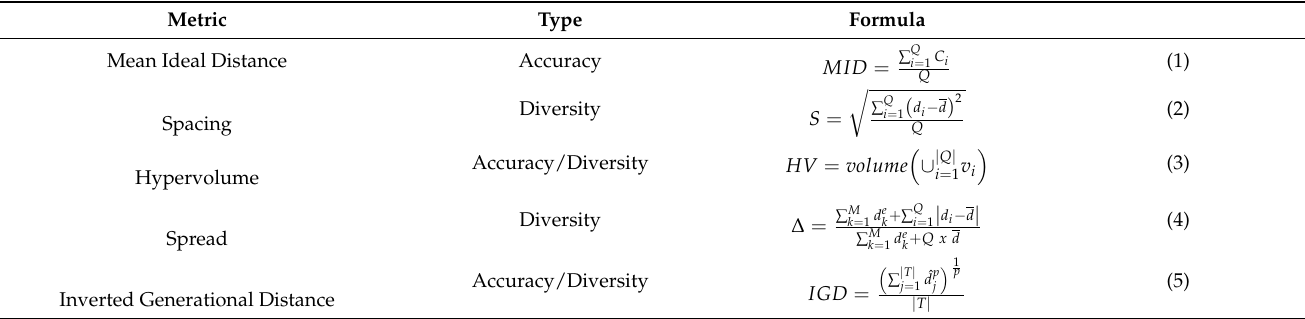
Table 1. Performance